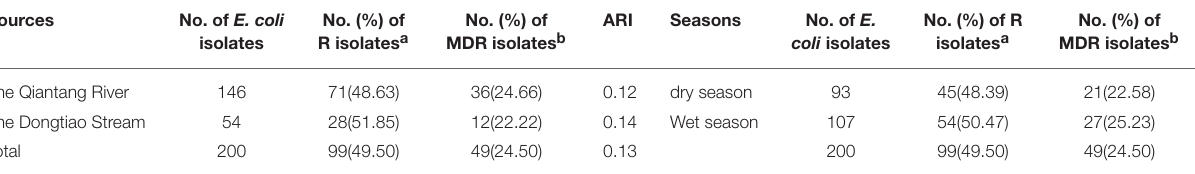
TABLE 3 | Antibiotic resistance of E. coli isolated from the Qiantang River and the Dongtiao Stream over two seasons. Sources